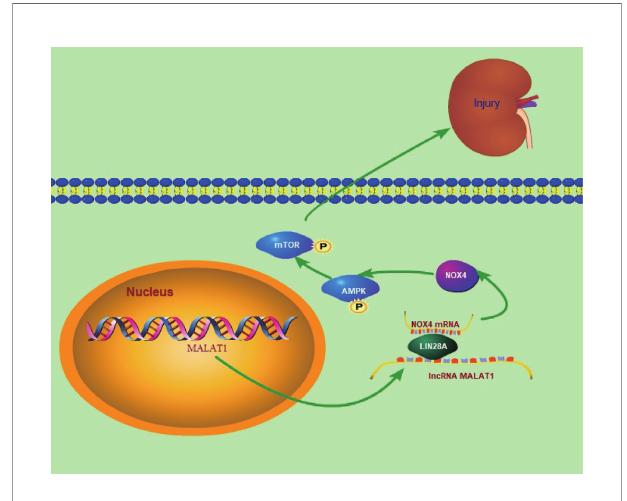
FIGURE 10 | The graphical abstract of the